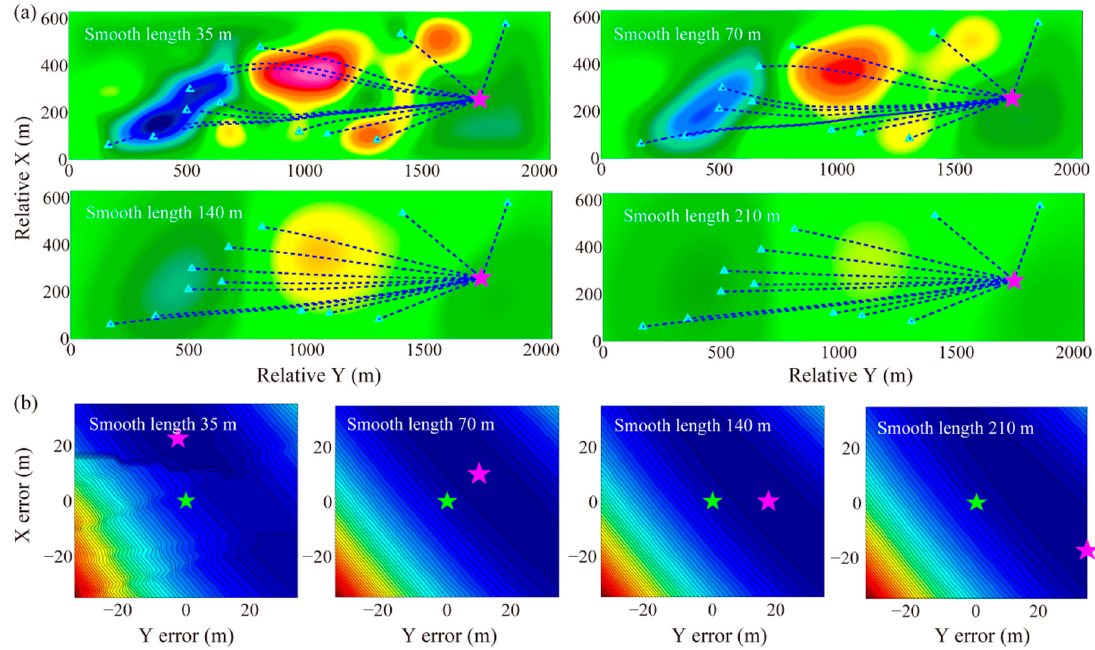
Figure 1. Grid search and waveform inversion-based (GSWI) location results under di ff erent velocity model smoothing scales. ( a ) Velocity models under di ff erent smoothing scales and ray paths from source to each triggered sensor. The 2D slices of 3D tomographic velocity models showing here are determined by the summation least square of the vertical distances from all sensors. The backgrounds are the smoothed velocity models with smoothing lengths equaling to 35, 70, 140 and 210 m, respectively. The dotted lines show the ray tracing paths from the source location to corresponding triggered sensors. ( b ) Waveform misfit contour map of GSWI location result at grid points near the true source location for di ff erent smoothing scales. The smoothing lengths from left to right are 35, 70, 140, and 210 m, respectively. The pink star is the location determined by the GSWI location method, while the green star corresponds to the true event location.